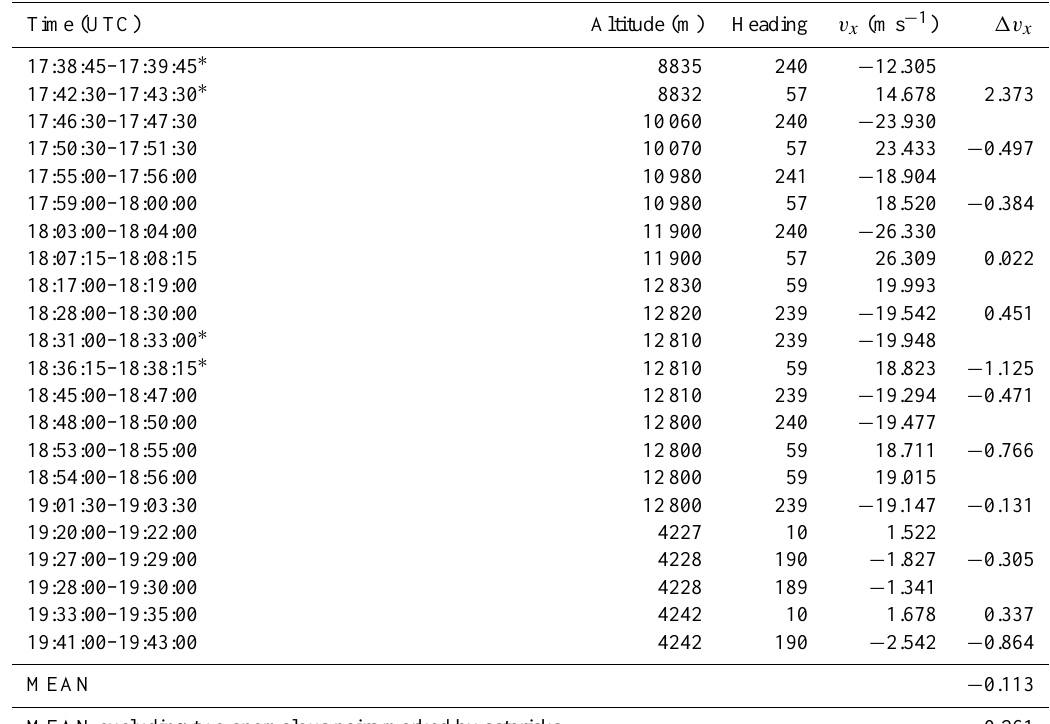
Table 1. Pairs of reverse-heading manoeuvres. Average values for altitude, heading and the longitudinal component of the wind ( v x ) are listed. Data from the GV flight of 6 August